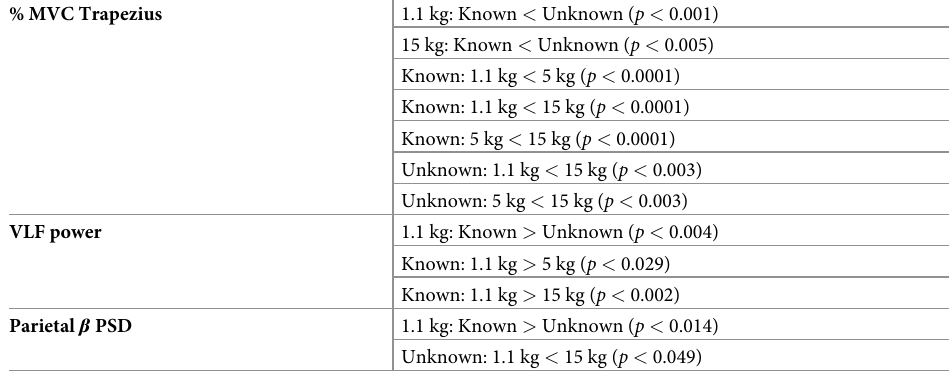
Table 4. Summary of significant contrasts where the interaction between the two independent variables was significant. % MVC Trapezius